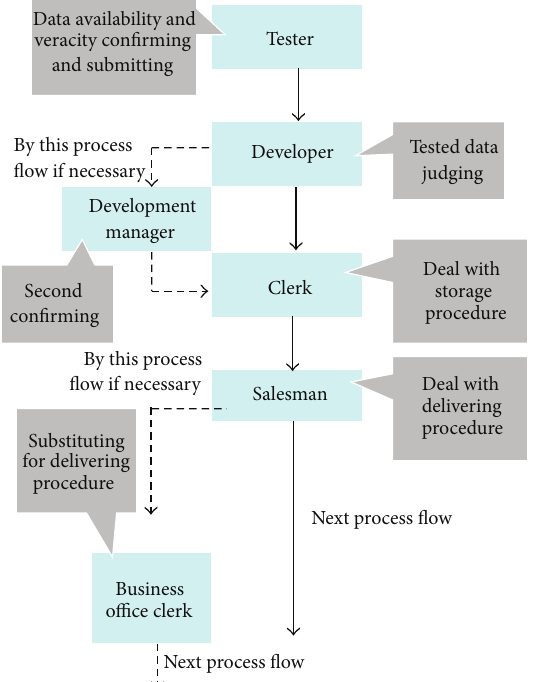
Figure 5: Flow chart of testing and judging and storage workflow.